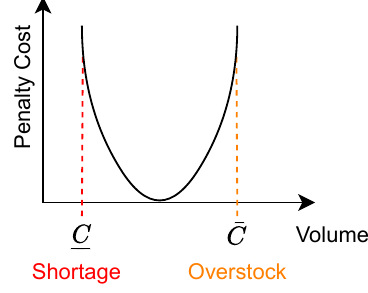
Figure 1. A quadratic function of the penalty